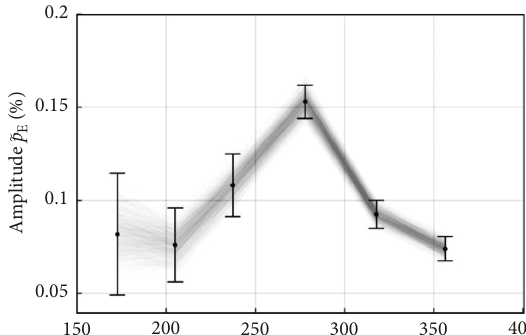
Figure 12: The first 1000 inputs to the MCM simulation of the amplitude data from pressure sensor R1. Each line is plotted with light color, and darker color represents coinciding lines. Mea- surement data are